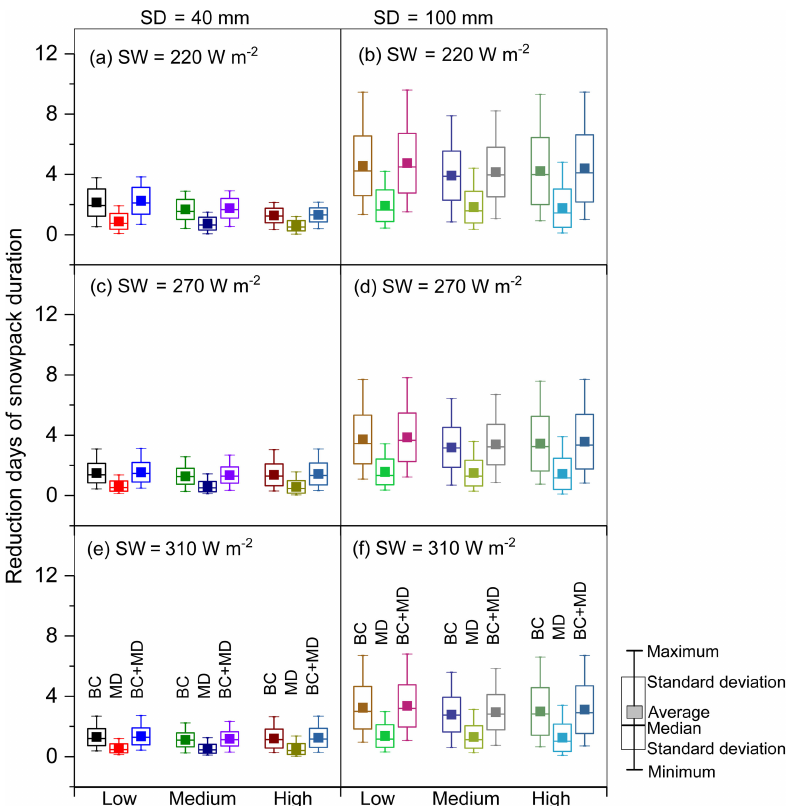
Figure 8. Reduction in days of snow cover duration by BC and dust for low, medium, and high scenarios due to albedo reduction at different snow depth (SD = 40 and 100mmw.e., respectively). Panels ( a, b ) were simulated based on the daily shortwave at 220Wm − 2 , ( c, d ) were simulated based on the daily shortwave at 270Wm − 2 , and ( e, f ) were simulated based on the daily shortwave at 310Wm − 2 . (Solid rectangles are average values, solid line in the box means the median, outliers of boxes are the 1 standard deviations of the average, and the bars are maximum and minimum